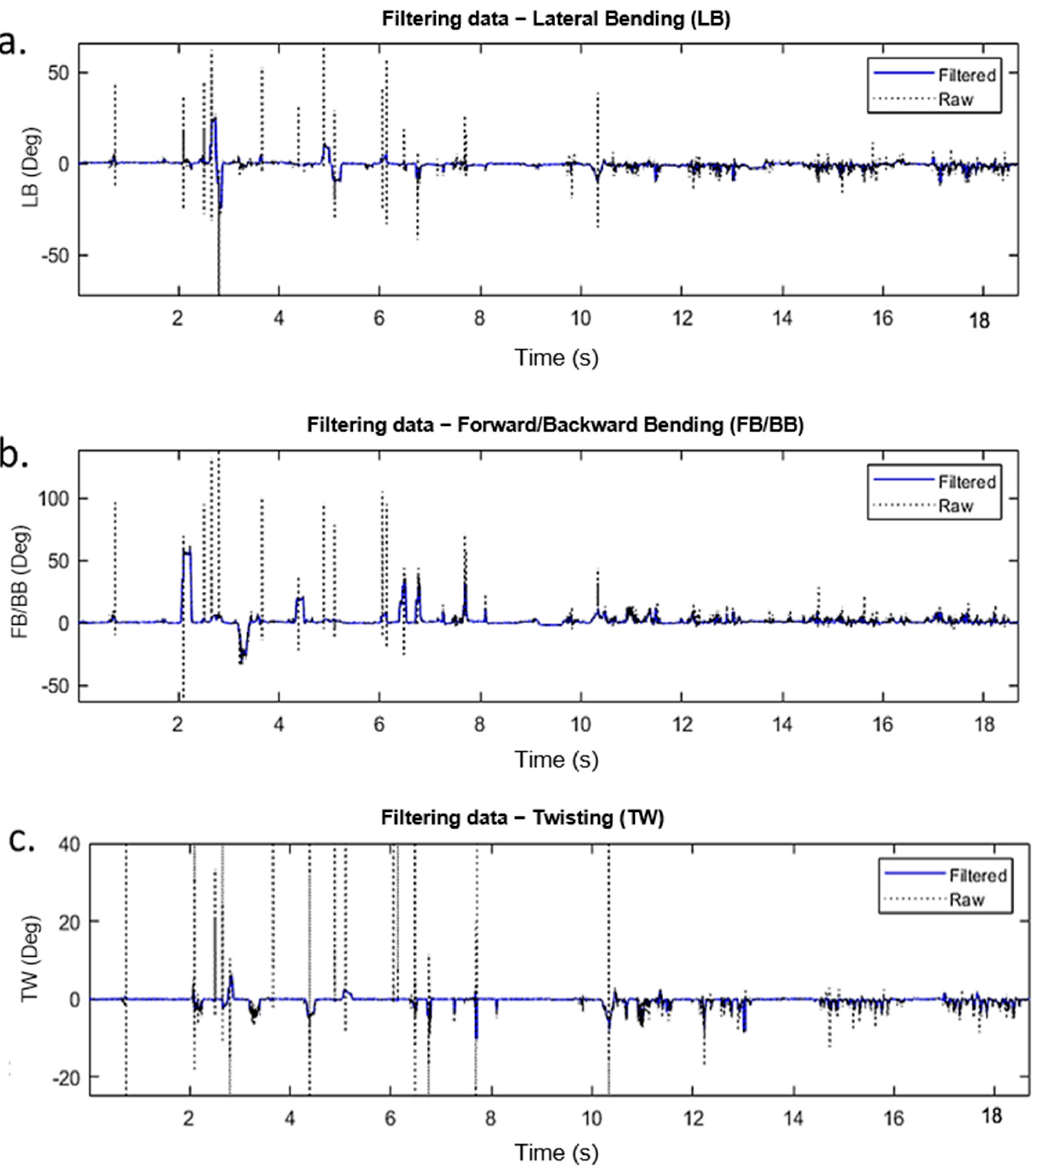
Figure 4. Raw vs. filtered data of a single participant using the medfilt function: ( a ) Lateral bending (LB), ( b ) forward/backward bending (FB/BB), and ( c ) twisting (TW).